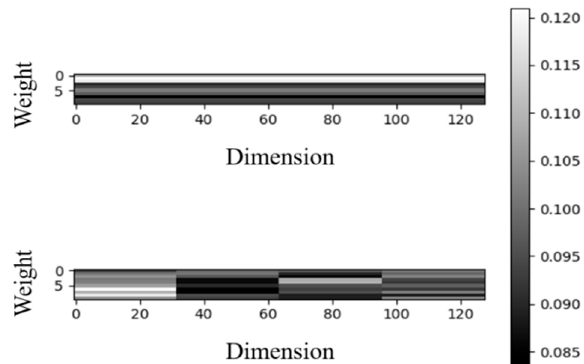
Figure 7. Di ff erence in weight of single / multi-head attention Figure 7. Difference in weight of single/multi-head attention models.